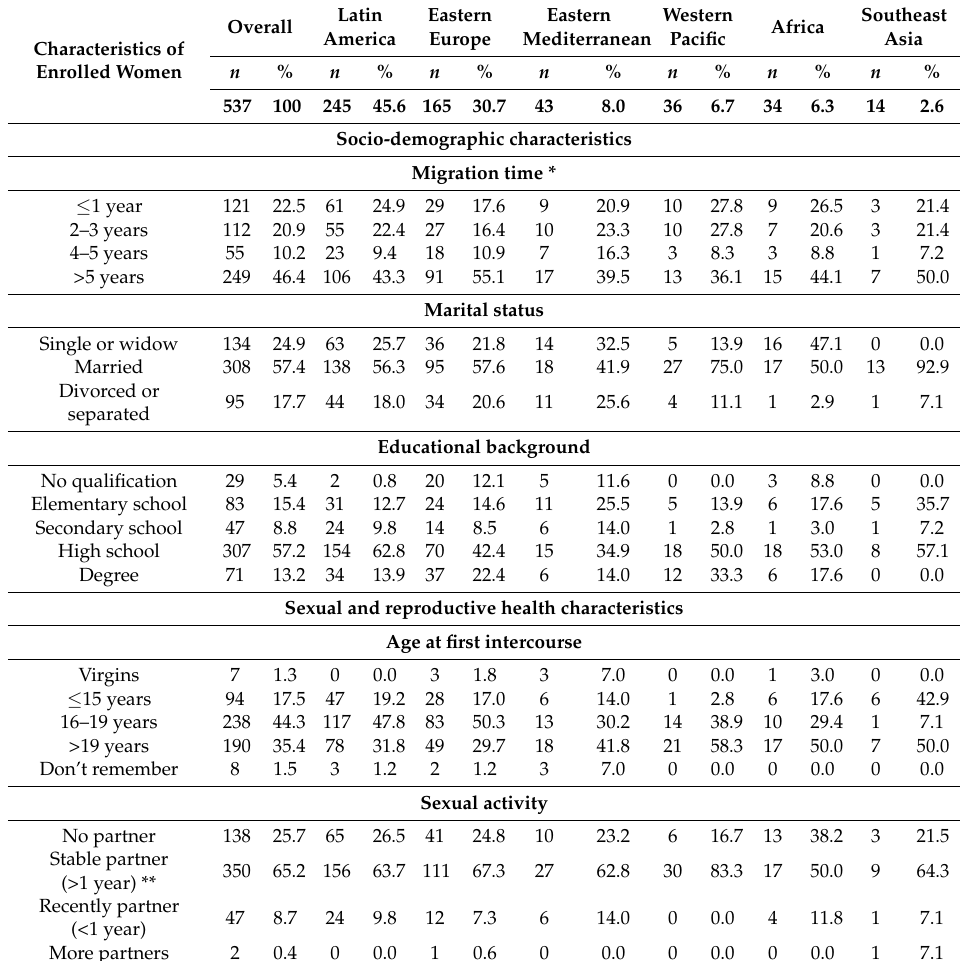
Table 1. Socio-demographic and sexual health characteristics of 537 women enrolled: overall and by geographical World Health Organization (WHO)